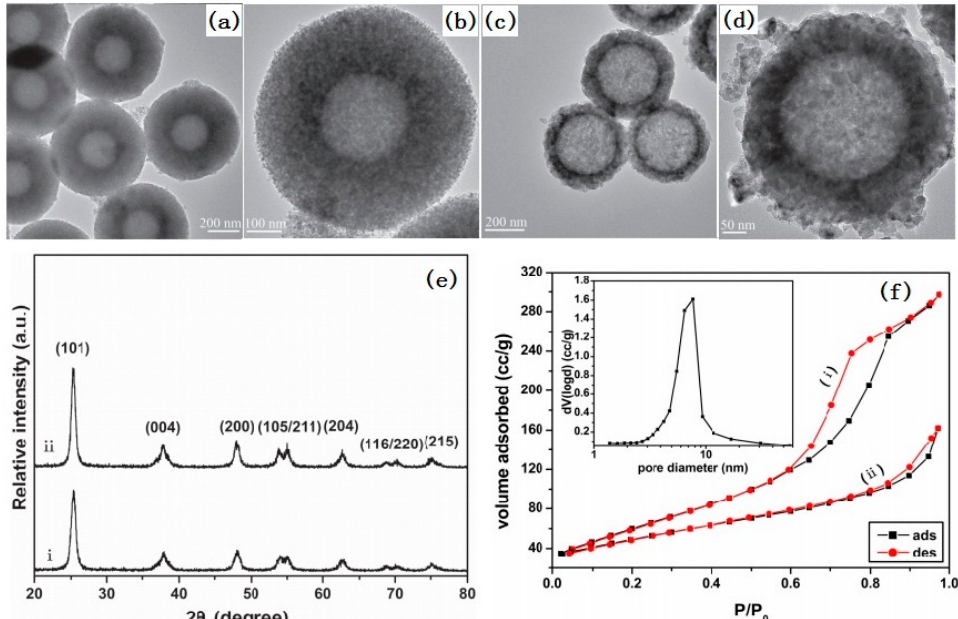
Figure 7. TEM images ( a , b ), XRD patterns ( e -i) and nitrogen adsorption-desorption isotherms ( f -i) of